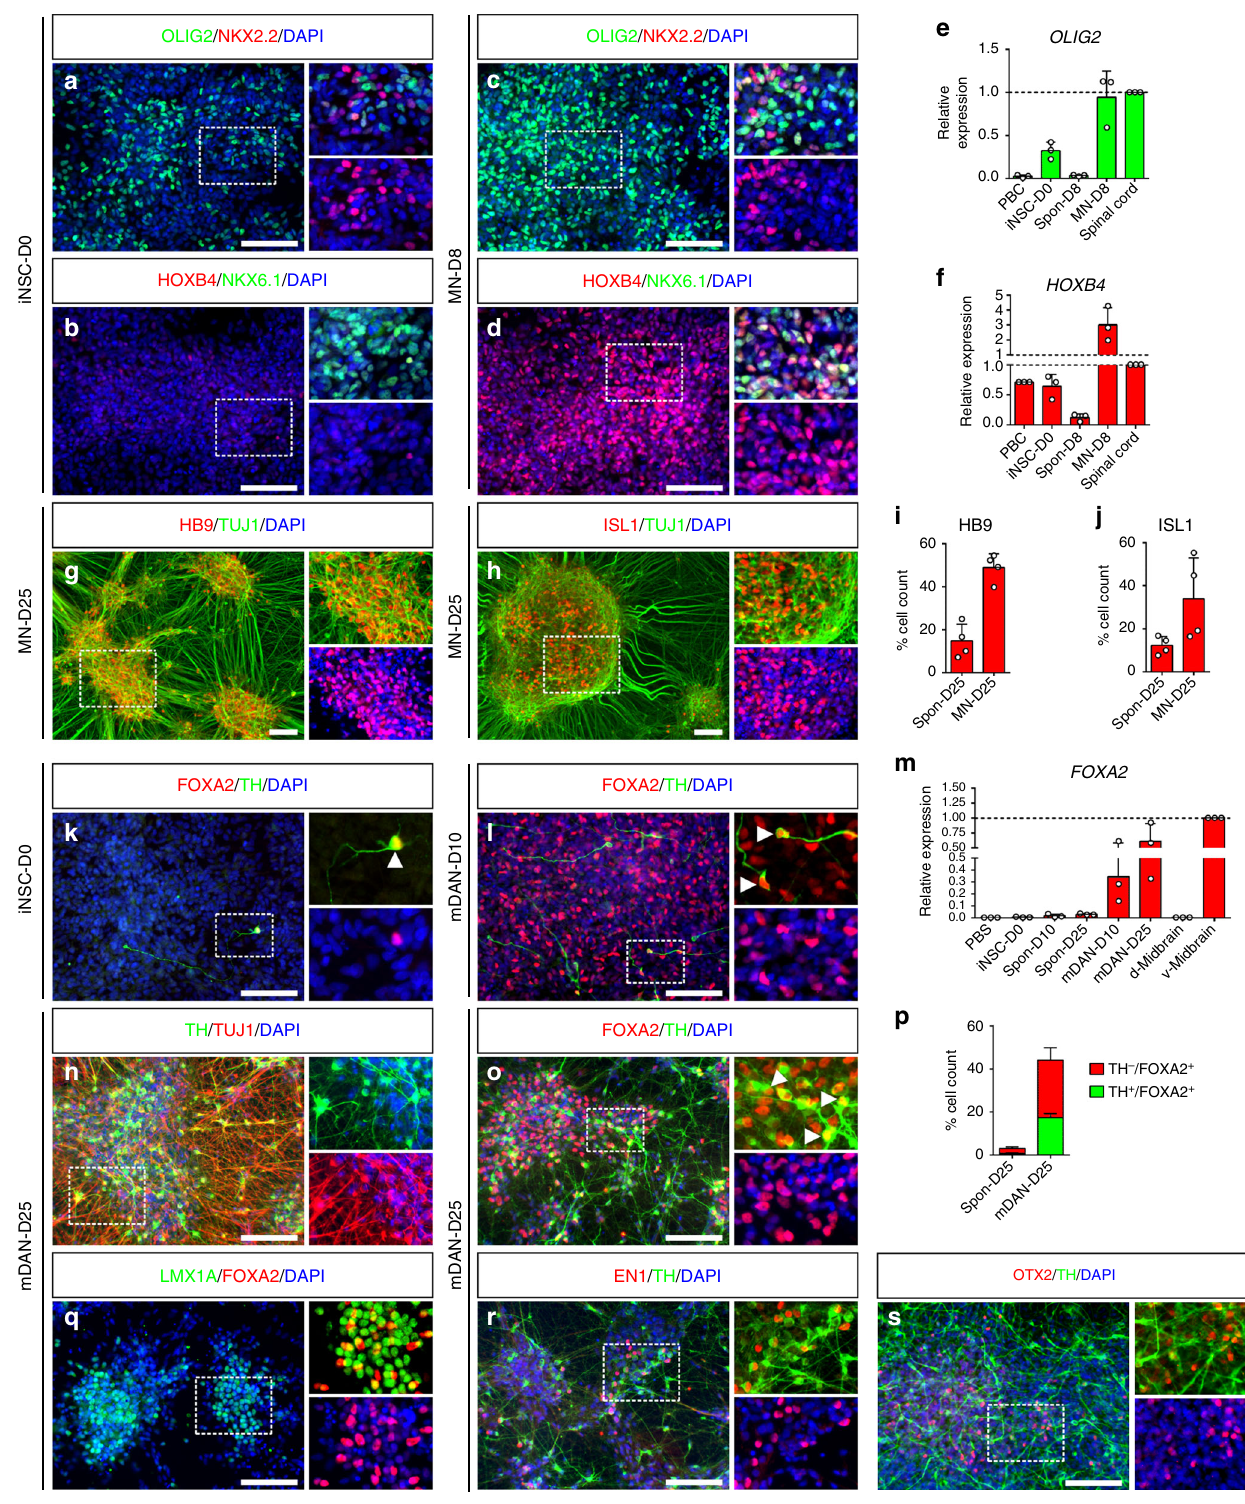
PSCs, PBCs, and NPCs including both ESC- and iPSC-derived NPCs and blood-derived iNSCs at low and high passages (Fig. 4g). Within the neural cluster, single- and poly-colony iNSCs shared highly similar DNAm pro fi les. Interestingly, iNSCs segregated according to low and high passage numbers, suggesting changes of DNAm pro fi les in iNSC cultures during extended in vitro culture. Thus, despite subtle differences, human blood-derived iNSCs display global gene expression and DNAm